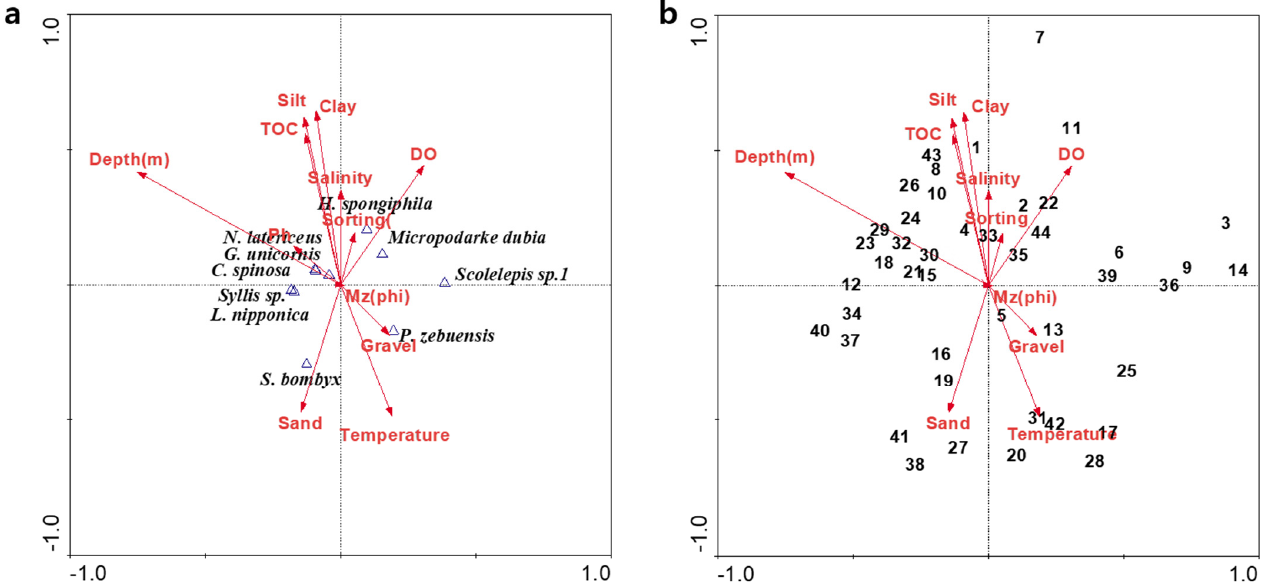
Figure 4. ( a ) Canonical correspondence analysis (CCA) biplot of the 10 most abundant polychaete species and 12 environ- mental variables. ( b ) Biplot of the sampling sites (1–11, 1902; 12–22, 1906; 23–33, 1908; 34–44, 1912) and 12 environmental variables at Ulleungdo island (Polychaete species: P. zebuensis , Pseudobranchiomma zebuensis ; H. spongiphila , Haplosyllis spongiphila ; L. nipponica , Lumbrineris nipponica ; C. spinosa , Chaetozone spinosa ; N. latericeus , Notomastus latericeus ; M. dubia , Micropodarke dubia ; S. bombyx , Spiophanes bombyx ; G. unicornis , Glycera unicornis ).